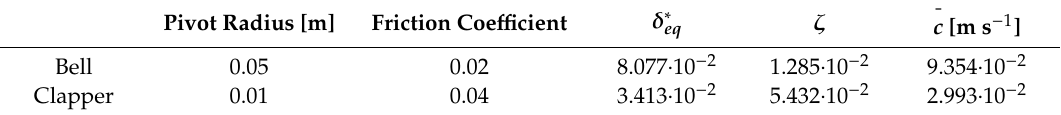
Table 8. Friction parameters and 5 ◦ equivalent viscous damping parameters of St. Mary’s tenor